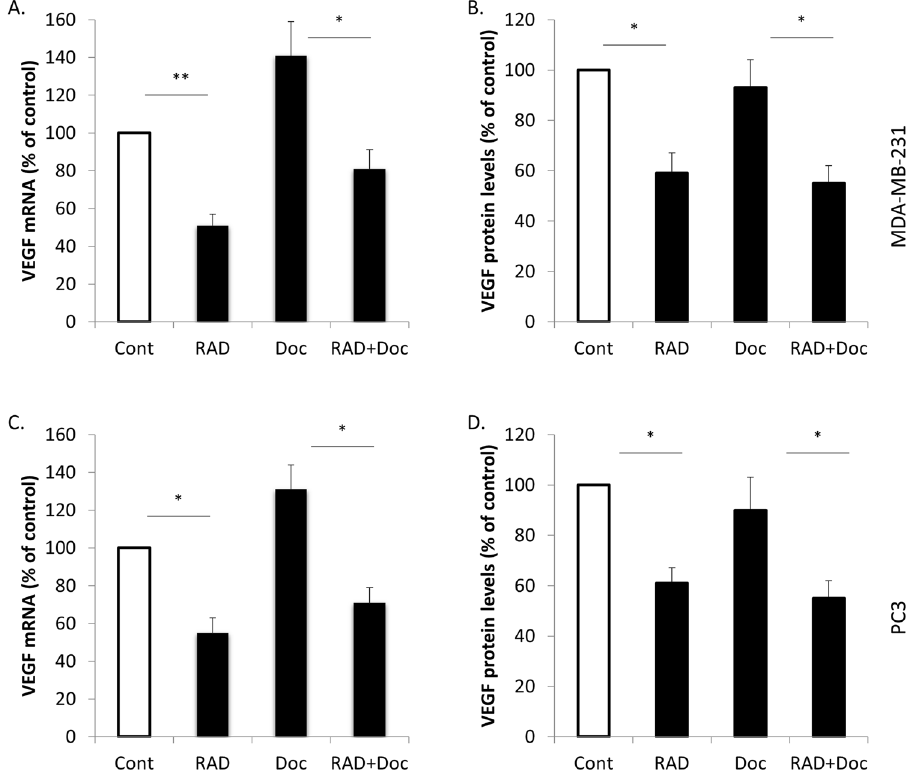
Figure 3. RAD001 but not docetaxel decreases VEGF expression in MDA-MB-231 and PC3 cells. MDA-MB-231 and PC3 cells were starved overnight then incubated with 0.1% DMSO (Cont), 100 nM RAD001 (RAD), 5 nM docetaxel (Doc) and the combination of these drugs (RAD + Doc) for 24 h. ( A , C ) VEGF expression was determined by qRT-PCR ( B , D ) VEGF protein levels were measured using ELISA. Columns, mean of three independent experiments performed in triplicate; bars, SEM. ( * P < 0.05; ** P < 0.01; § P < 0.001; ns, not significant, P >